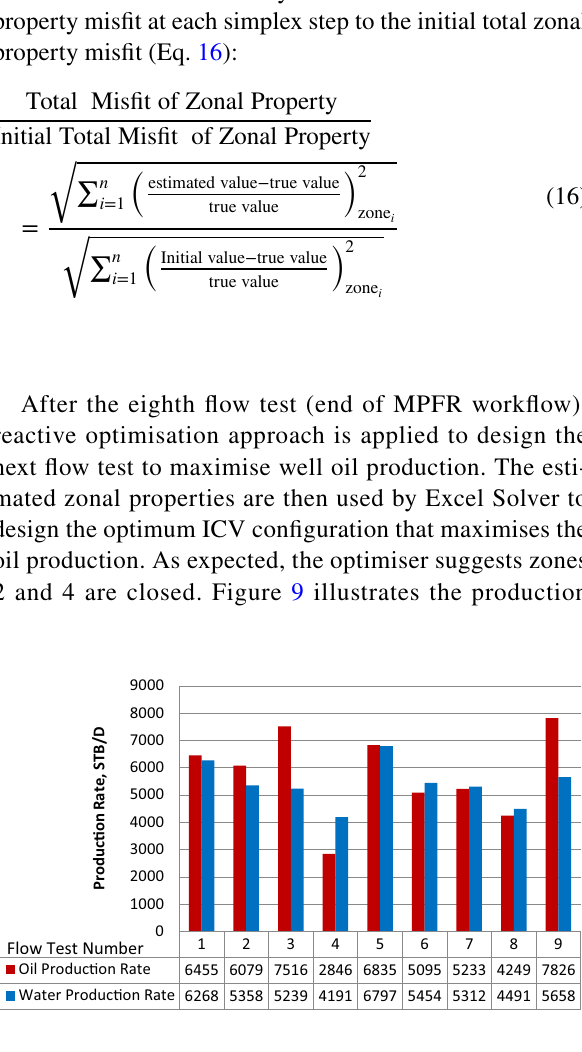
Fig. 9 Total oil and water flow rates for the ninth flow tests required when the control and monitoring steps are separated